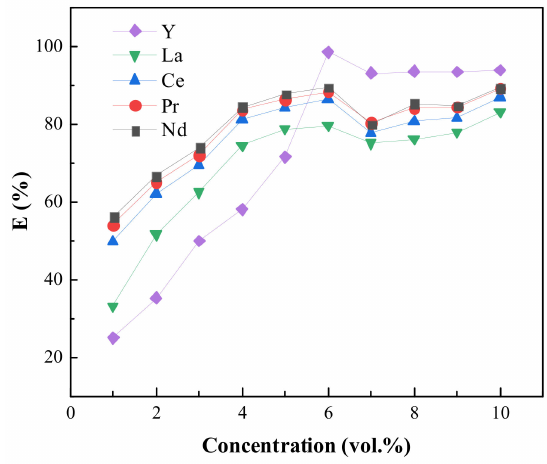
Figure 2. Effect of extractant volume concentration on the extraction of